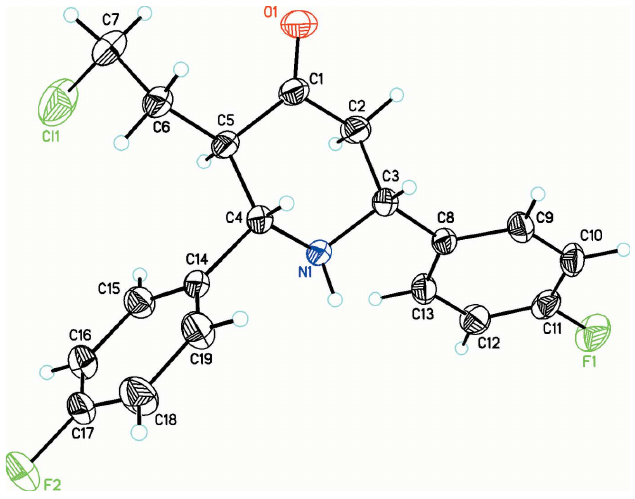
Figure 2 Aview of the molecular structure of (II), showing displacement ellipsoids drawn at the 30% probability level.